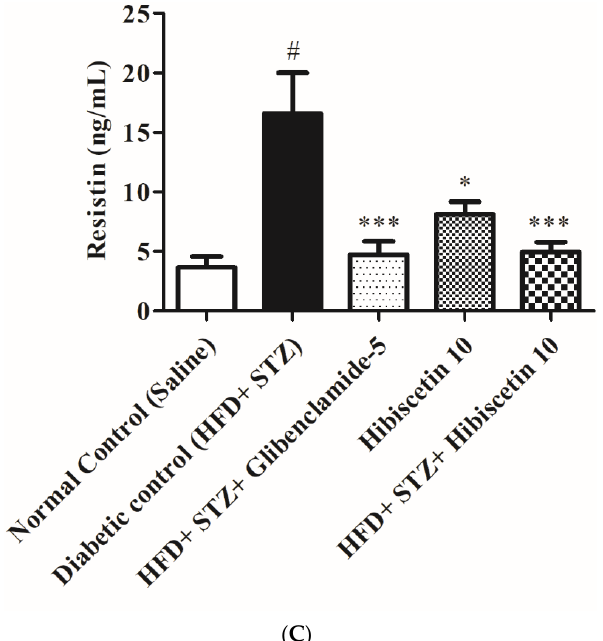
Figure 6. ( A – C ) Effect of hibiscetin on resistin, leptin, adiponectin and resistin (n = 6). The mean SEM is used to express the data; ( # p < 0.05) saline vs. HFD+STZ, (*** p < 0.001, ** p < 0.01, and * p < 0.05) HFD+STZ vs. treatment group.